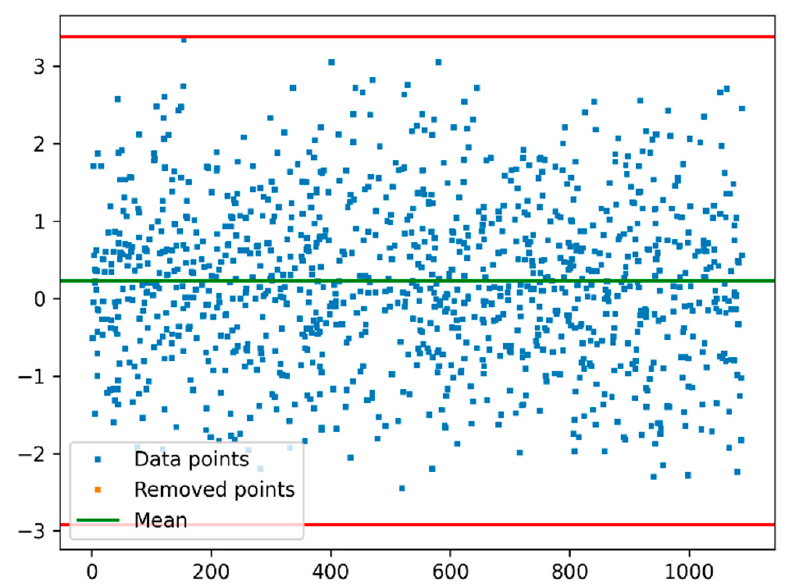
Figure 3. Endpoint distribution for pIGC50 against T. pyriform : in green the endpoint average, in red the upper and down limits that are 3 σ from the mean.